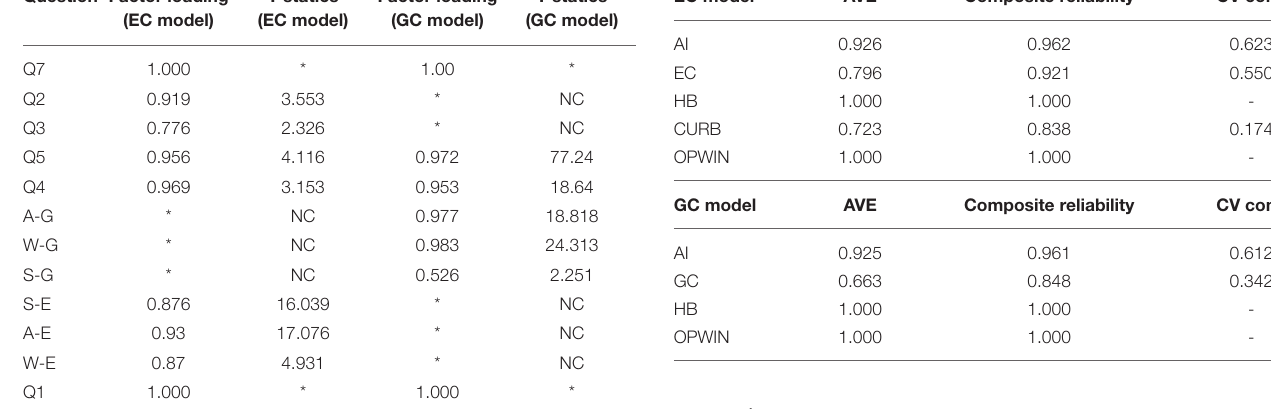
TABLE 8 | Path coefficients and